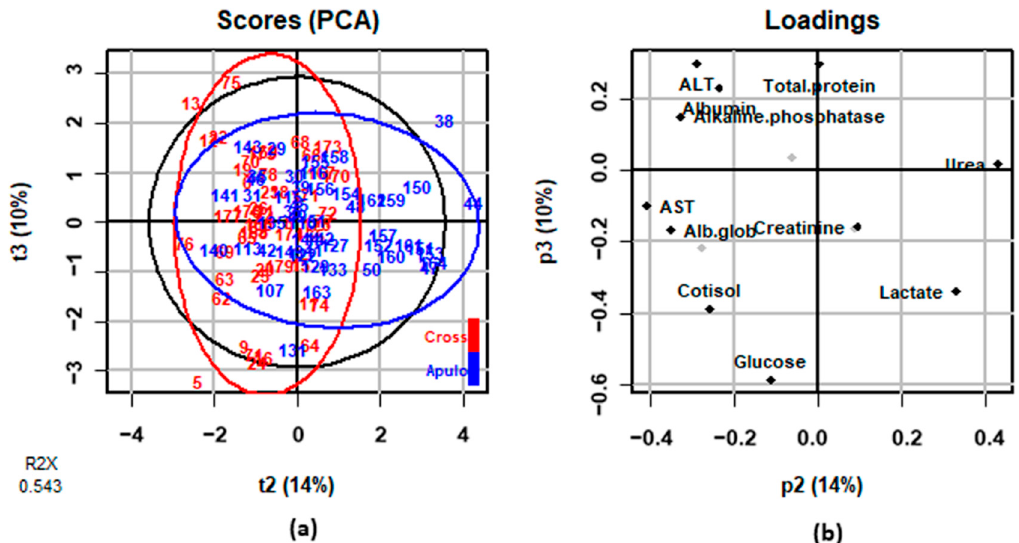
Figure 1. Results of principal components analysis (PCA) on the variations of blood parameters between T1 and T0: ( a ) score plots for principal component 2 (t2) and principal component 3 (t3) of Apulo-Calabrese (blue) and crossbreeds (red) samples; ( b ) loadings plot with the weights of variables included in principal component 2 (p2) and principal component 3 (p3).